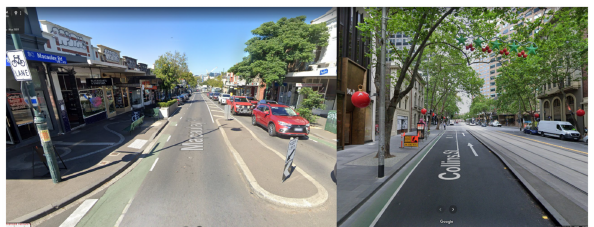
Figure 1. Google Street View screengrabs showing examples of cycle lanes being ‘squeezed in’ within the City of Melbourne cycle lanes that are narrow (less than 0.6 m wide) and do not provide physical separation by a concrete curb. ( left ) Kensington and ( right ) Collins Street